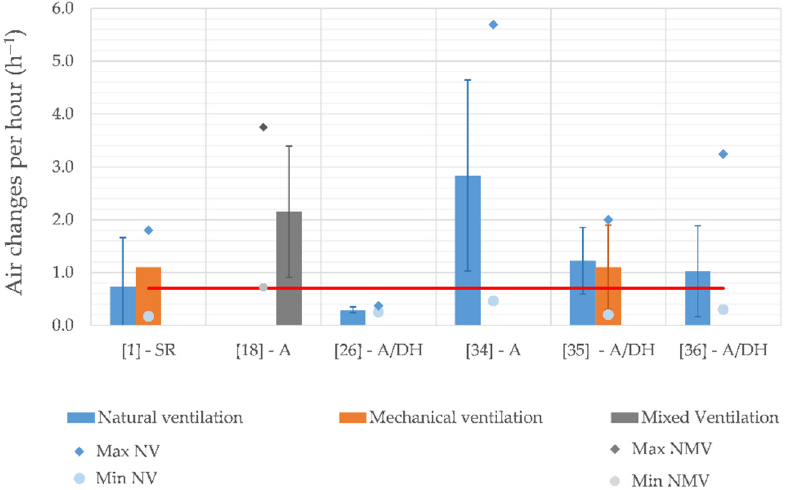
Figure 10. Air changes per hour during the sleep period in bedrooms in different types of building (A—apartment; A/DH—mixed (apartment and detached house); SR—scholar residence) and different types of ventilation settings (NV—natural; mechanical—MV; mixed—NMV). Bars provide mean values (along with standard deviation when available). Red line stands for the minimum value of 0.7 h − 1 established for bedrooms by EN 16798-1:2019 [47].